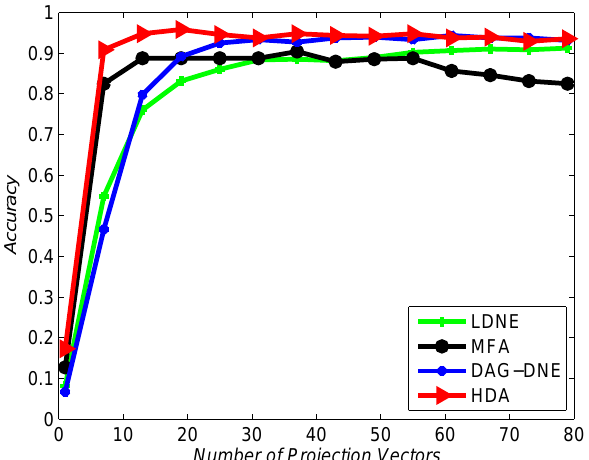
Figure 11. Accuracy vs. Number of Projection Vectors on the ORL dataset under K =